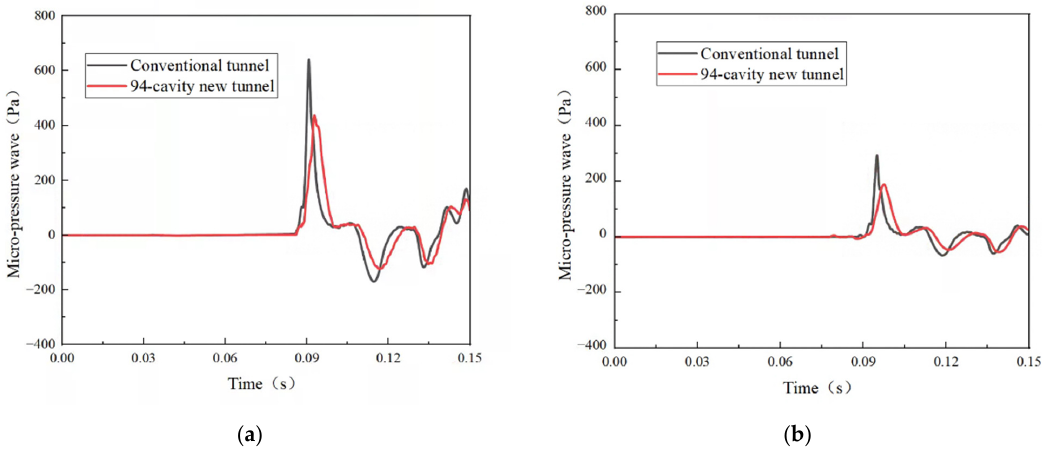
Figure 11. Effect of different solutions on micro-pressure waves. ( a ) M-2; ( b ) M-3 . Table 3. Comparison of results of different solutions